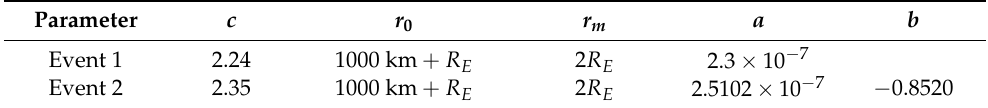
Table 3. Modification parameter for event 1 and event 2.